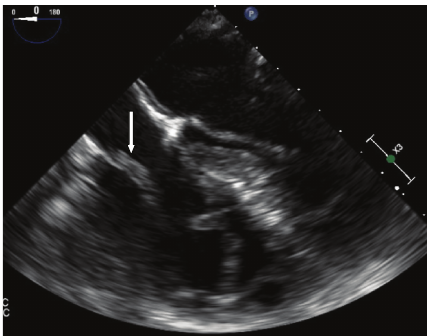
Figure 1: TEE image (apical four-chamber view) showing a serpig- inous, elongated echodensity measuring 8.4 cm × 0.5 cm prolapsing into the tricuspid valve orifice deep into right ventricle; the attach- ment appears to be along the anterolateral right atrium.